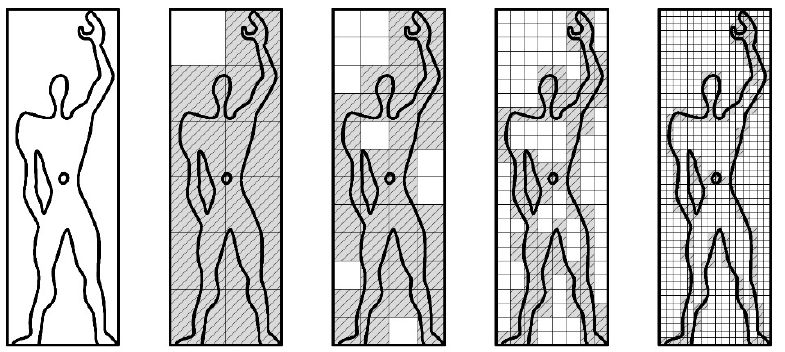
Figure 5. Four stages of box-counting for Le Corbusier’s Modulor with hatching to indicate grids that contain information.